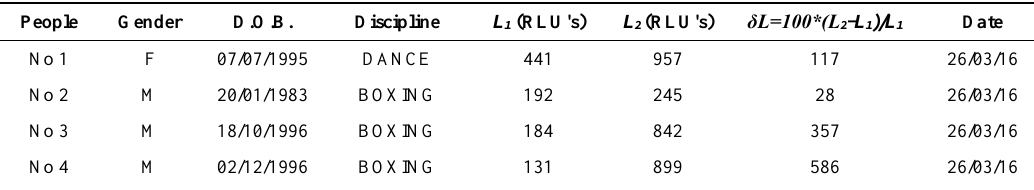
Table 4. The Test results of ATP test for the ten people from